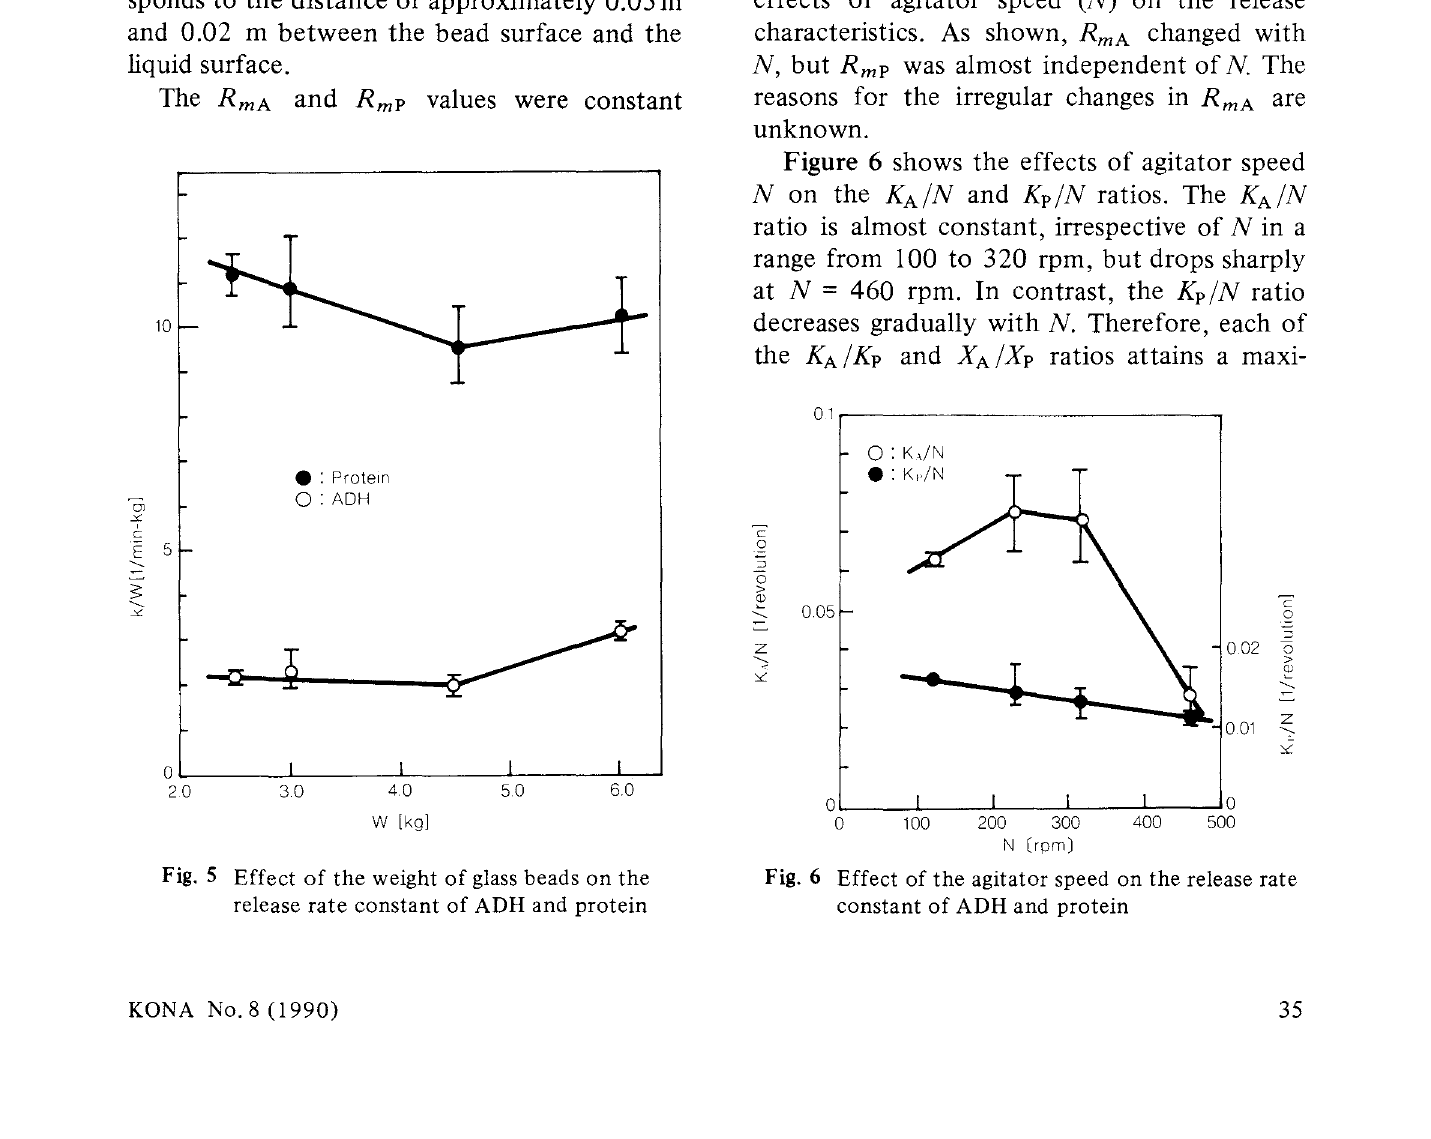
Fig. 6 Effect of the agitator speed on the release rate constant of ADH and